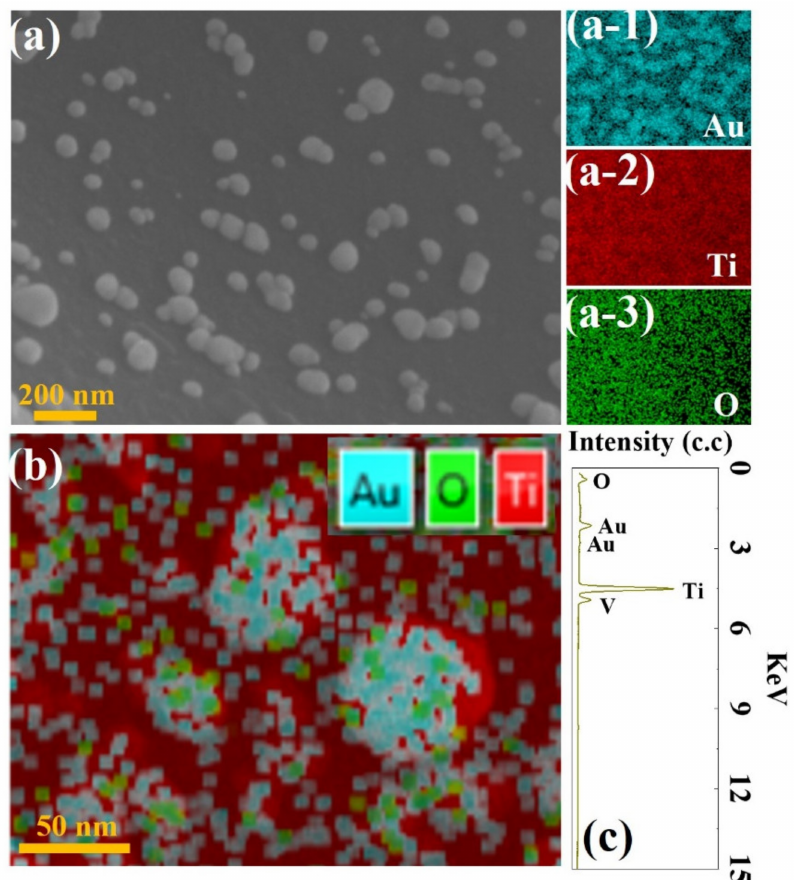
Figure 6. ( a ) SEM image and (a-1, a-2, a-3) the corresponding EDS elemental mappings for Au, Ti and O, ( b ) overlapped EDS elemental mapping for Au, Ti and O, ( c ) EDS spectrum of the Au/Ti (6 min) after the LTST.